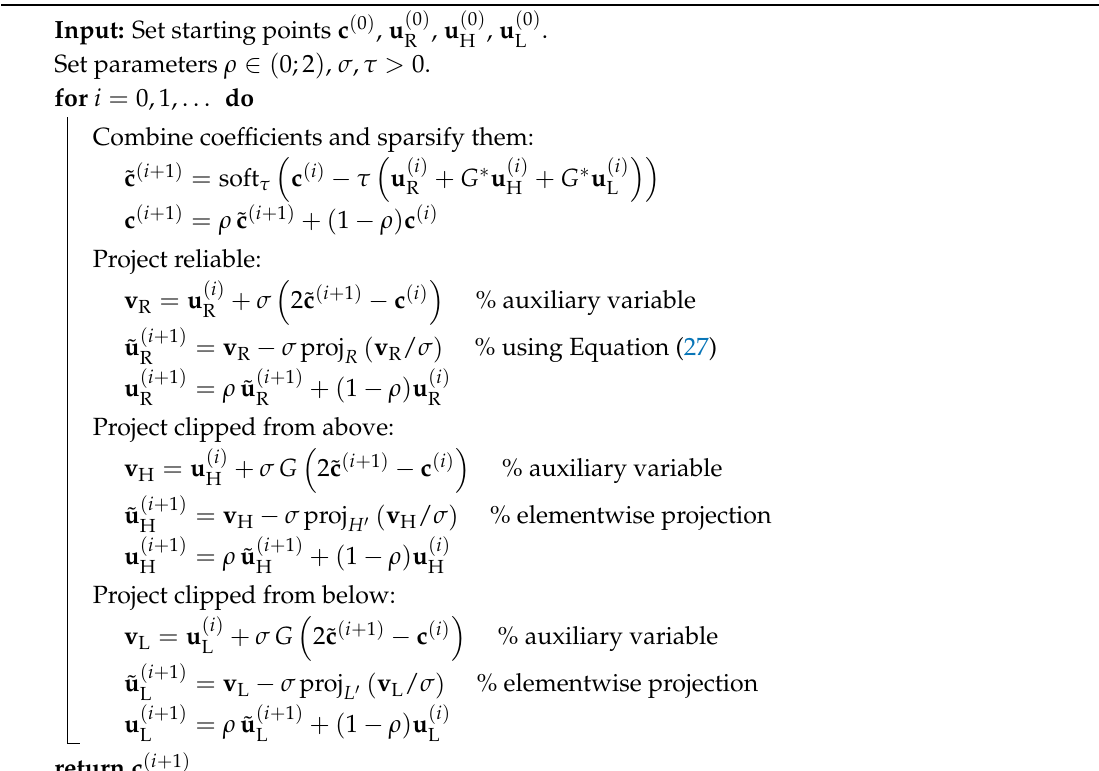
Algorithm 1: Condat algorithm (CA) adapted to solving Equation